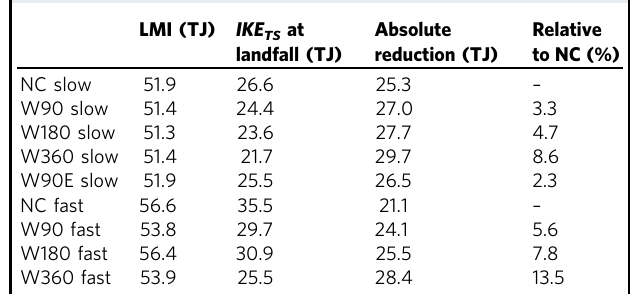
Table 2 As in Table 1, for IKE TS . Table 1 Lifetime maximum intensity (LMI, hPa), P min at